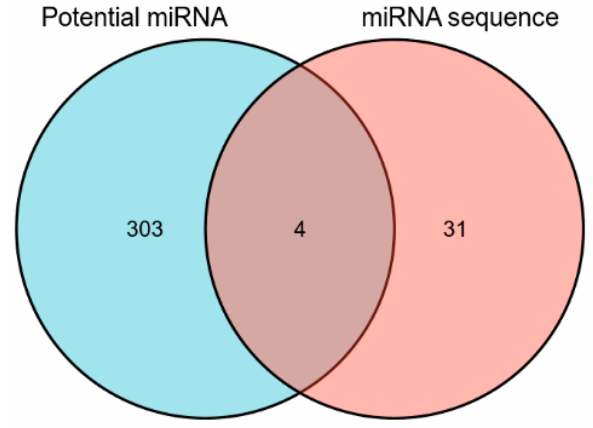
Figure 4. Overlapping miRNAs derived from text mining and from miRNA sequencing.